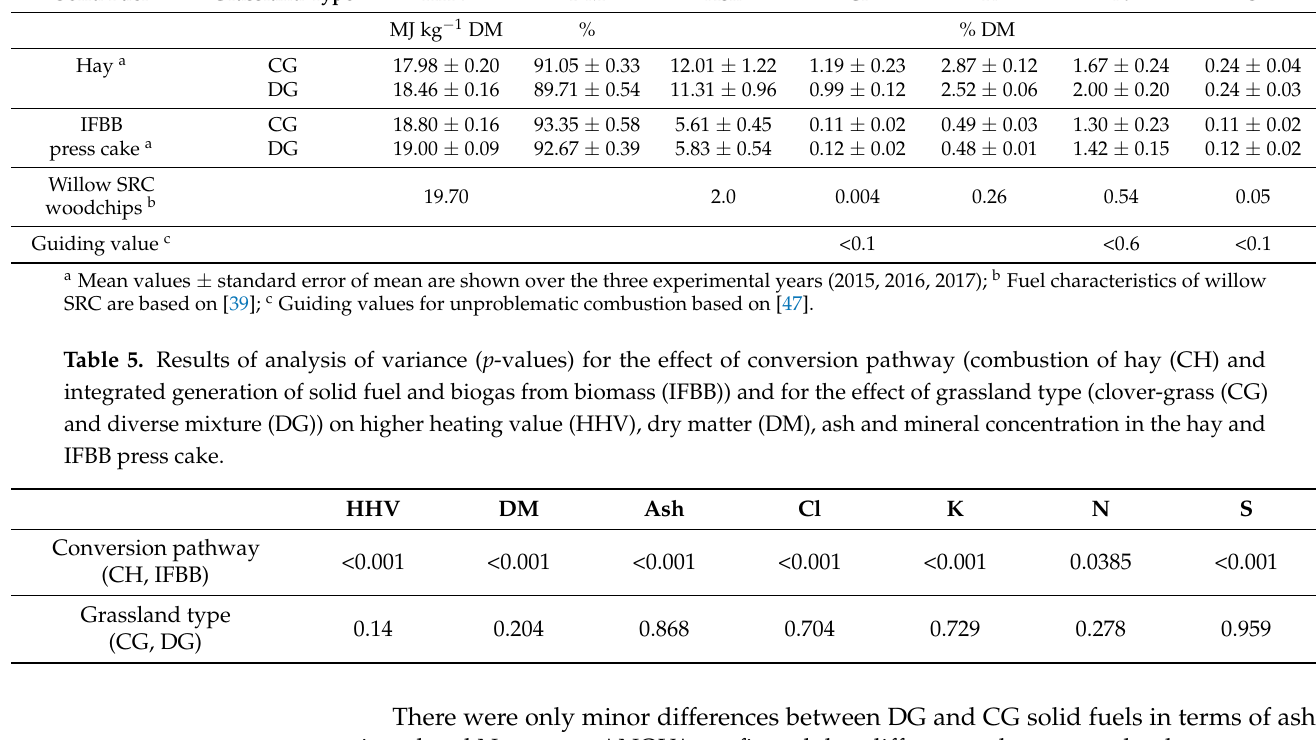
Table 4. Fuel characteristics of hay, integrated generation of solid fuel and biogas from biomass (IFBB) press cakes and willow short rotation coppice (SRC) woodchips produced from two alley-cropped grassland mixtures (clover-grass (CG) and a diverse mixture (DG)). HHV= higher-heating value, DM = dry matter. Solid Fuel